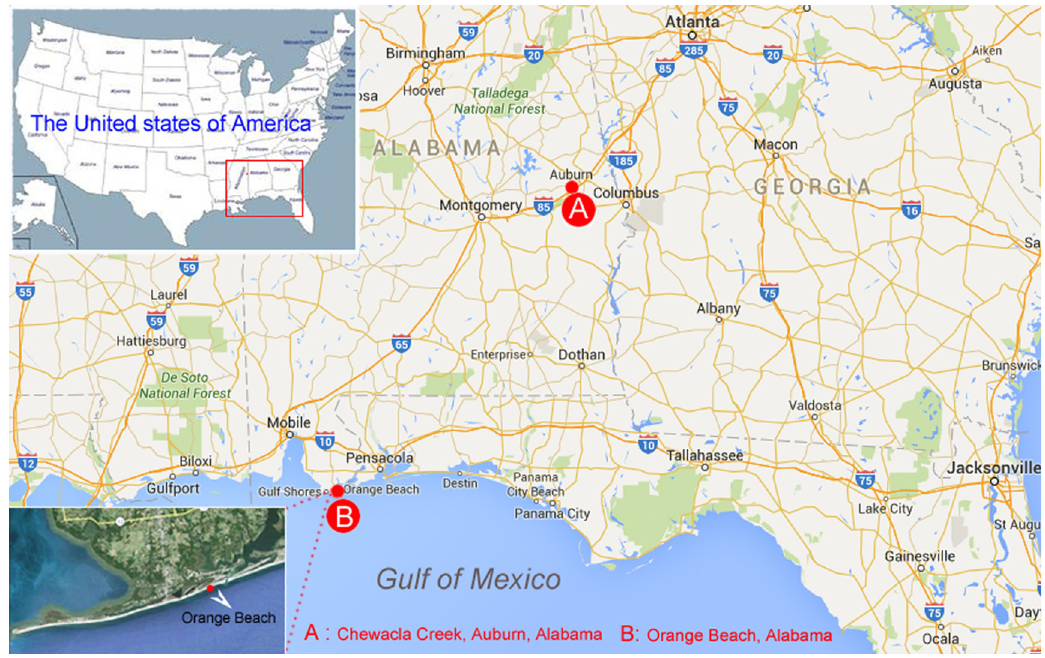
Fig. 1. Sampling map. A . Chewacla Creek, Auburn, Alabama (32º36′56″ N, 85º28ʹ58″ E). B . Orange Beach, Alabama (30º16′44″ N, 87º33′35″